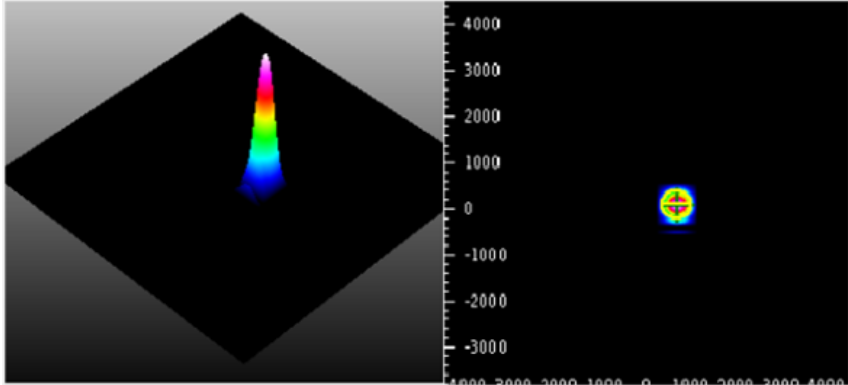
Figure 7. 2D and 3D output beam profiles of Tm,Ho:LuVO 4 laser.